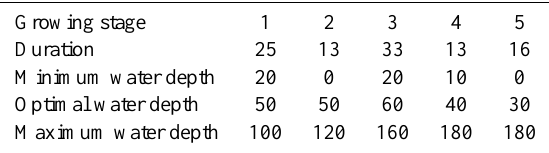
Table 1. The duration of each growing stage with the percentage of total growing duration and maintained water depth (unit: mm) in each growing stage for optimal rice paddy field